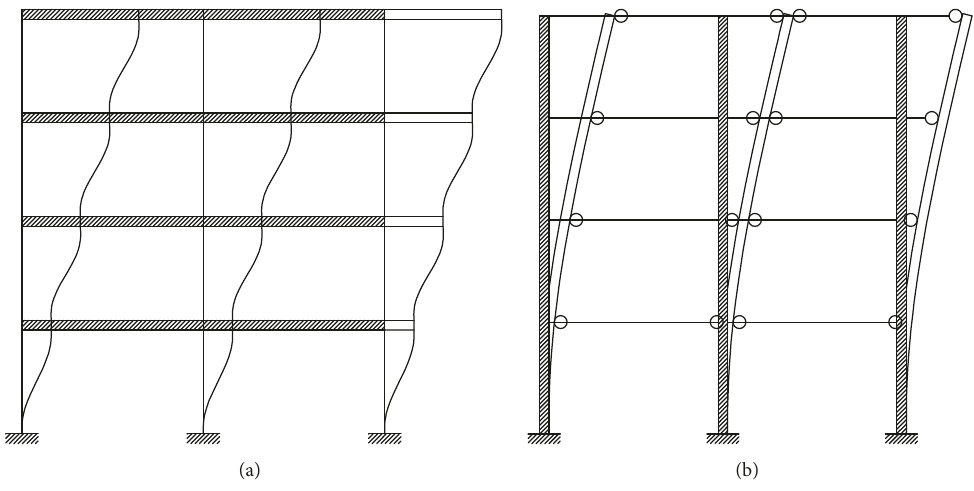
Figure 4: Modeling limit cases for a plane